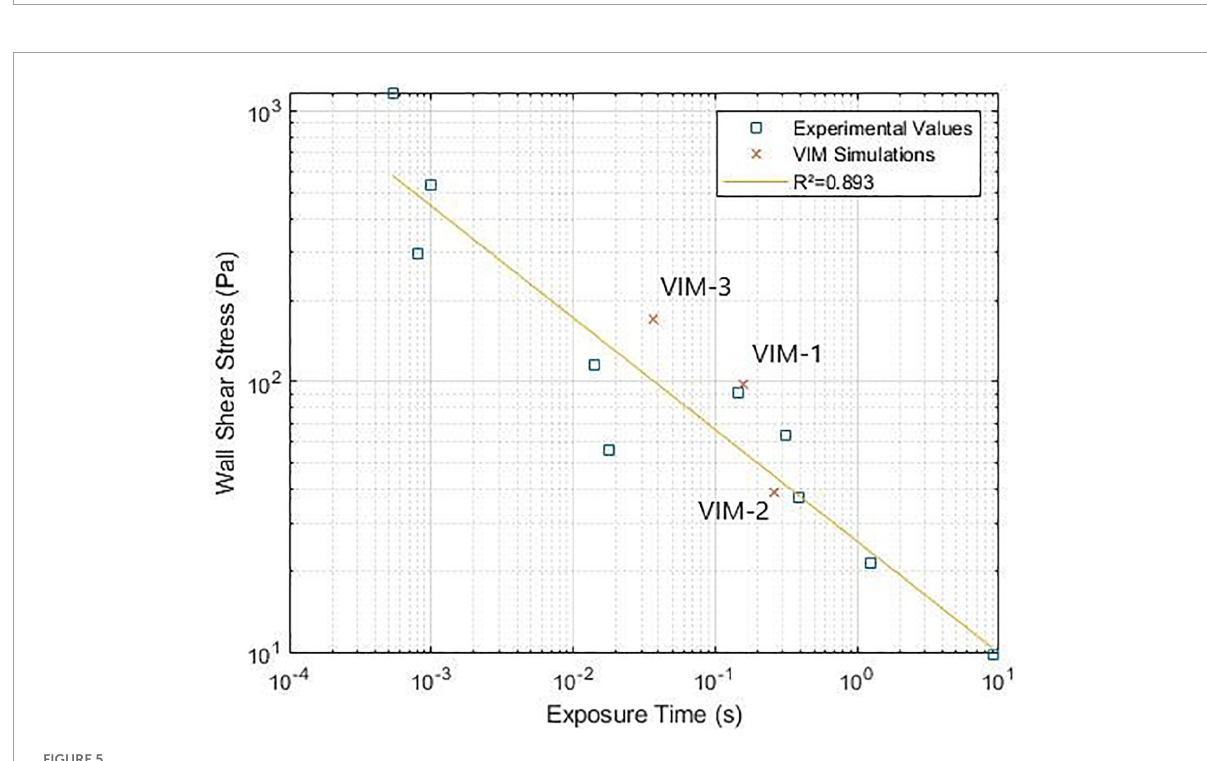
Frontiers in Cardiovascular